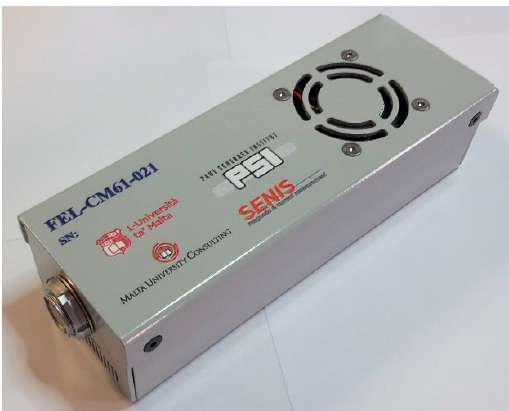
Figure 8. The final developed instrument with external physical dimensions of the aluminum enclosure of 150 mm by 50 mm by 45 mm.